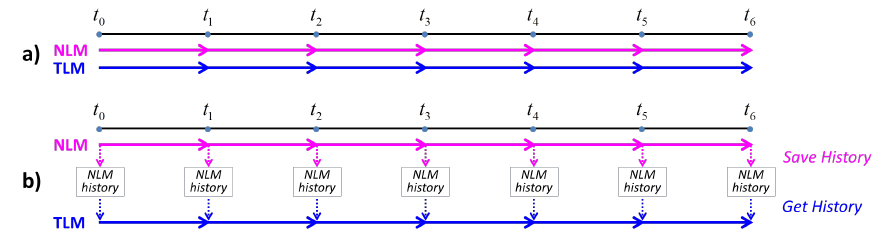
Figure 3. Nonlinear trajectory management for the tangent linear model. (a) Before the tangent linear model (initial version of TLM) is integrated, the nonlinear model (NLM) is calculated every time step ahead. (b) Nonlinear solutions are first saved during the time integration of the NLM, and then the TLM is integrated over time with coefficients from the NLM run.